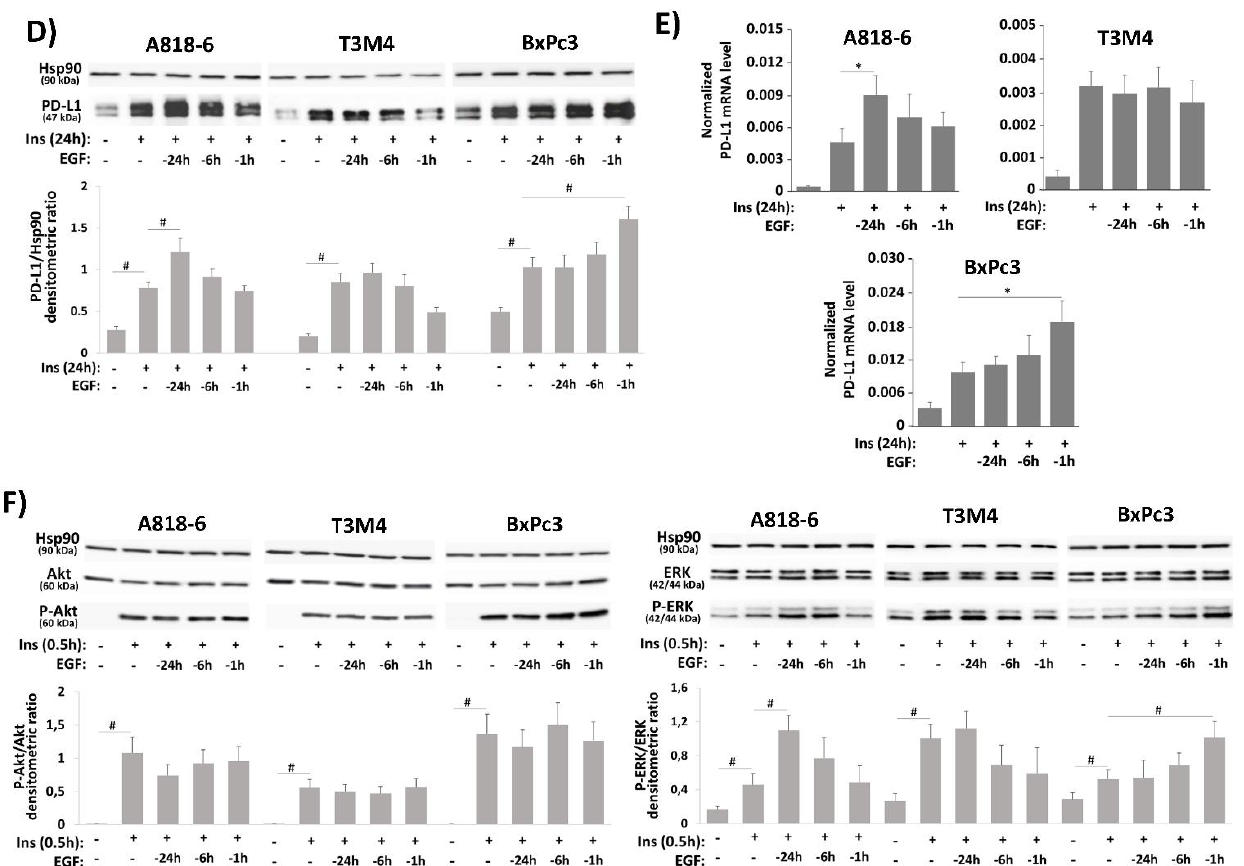
Figure 4. Crosstalk of insulin and EGF in inducing PD-L1 expression in PDAC cells. ( A – C ) Serum-starved A818-6, T3M4, and BxPc3 cells were either left untreated or treated with 0.1 IU/mL insulin for 24 h ( A , B ) or 16 h ( C ) either alone or in the presence of 10 ng/mL EGF. ( A ) Immunostaining of surface PD-L1 expression and fluorescence flow cytometry. A repre- sentative result from five independent experiments is shown. The percentage of PD-L1 positive cells (boxed areas in the histograms) are depicted in the graph below (mean ± SD, n = 5, * p < 0.05). ( B ) Western blot analysis using PD-L1 and Hsp90 antibodies. ( C ) qPCR analysis using PD-L1 and RPL13 primers. ( D , E ) Serum-starved A818-6, T3M4, and BxPc3 cells were insulin treated as above either alone or following preincubation with 10 ng/mL EGF for the indicated periods. Then, cells were submitted to ( D ) Western blot analysis using PD-L1 and Hsp90 antibodies or ( E ) to qPCR analysis using PD-L1 and RPL13 primers. ( F ) Serum-starved A818-6, T3M4, and BxPc3 cells were either left untreated or were treated with 0.1 IU/mL insulin for 20 min either alone or after preincubation with 10 ng/mL EGF for the indicated periods. Then, Western blot analysis for P-ERK1/2, ERK1/2, P-Akt, Akt, and Hsp90 was performed. ( B , D , F ) Representative blots from four inde- pendent experiments and band densitometry analyses (lower panels, # p < 0.05, n = 4) are shown. ( C , E ) PD-L1 mRNA expression is normalized to the expression level of RPL13, and data represent the mean ± SD from four independent experiments; (* p < 0.02).